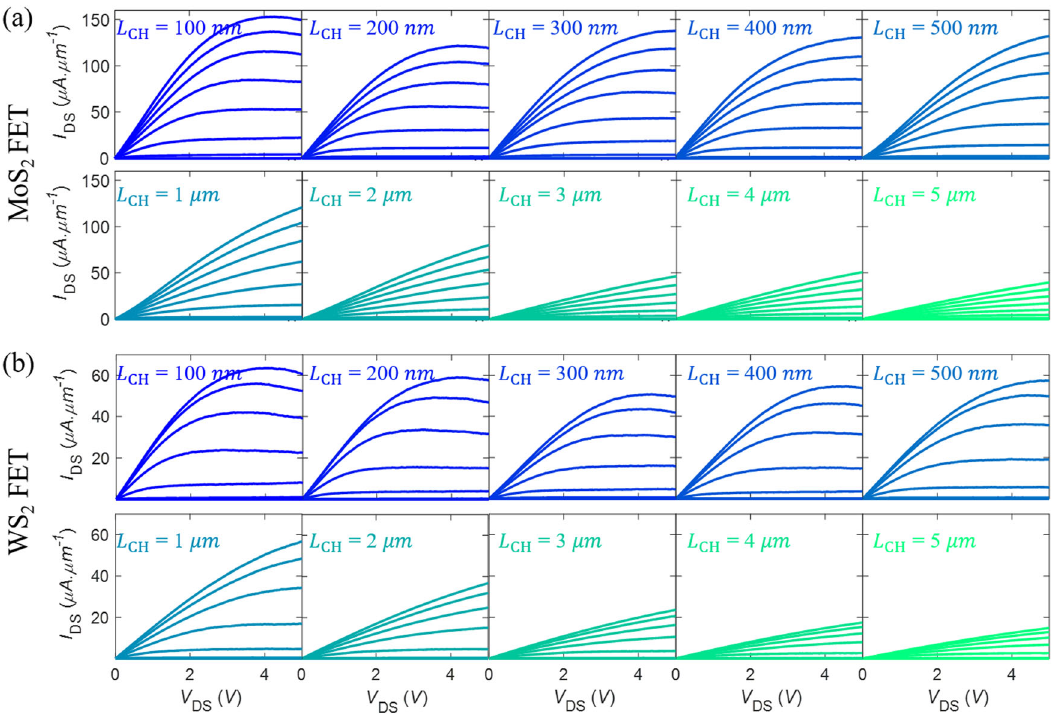
Fig. 6 ON-state performance of monolayer MoS 2 and WS 2 FETs. Output characteristics for channel lengths ranging from L CH = 100 nm to L CH = 5 μ m, obtained from a representative transmission-line measurement structure for a MoS 2 and b WS 2 FETs. Current saturation is achieved in shorter-channel devices for both MoS 2 and WS 2 FETs.